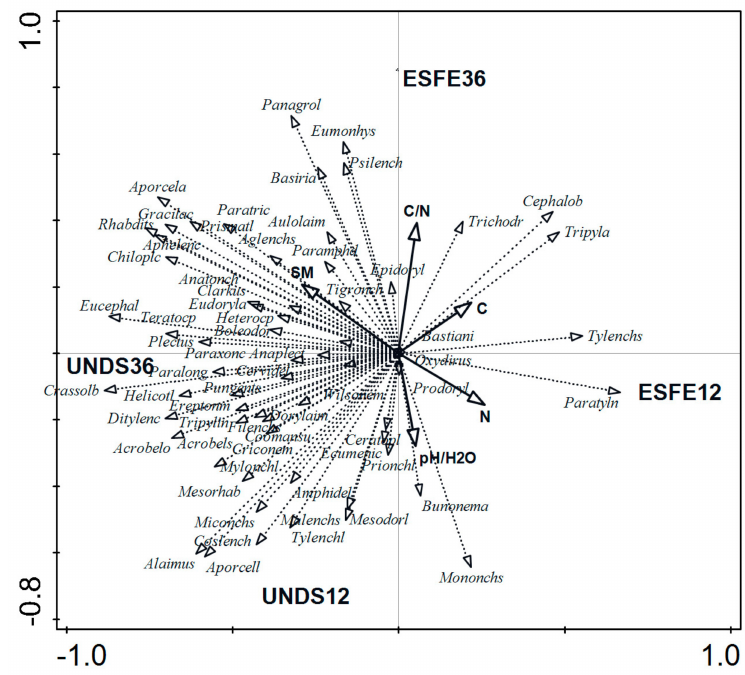
Figure 2. Genus scatter plot of Principal Component Analysis, 1st and 2st axis, log(y + 1) transformed genera abundance, soil attributes in disturbed early-successional forest ecosystems (ESFE12, ESFE36) and undisturbed plots (UNDS12, UNDS36), 12 and 36 months after event. Eigenvalues are 0.229, 0.127, 0.089, and0.075forfirst(horizontal), second(vertical), third, andfourthaxes, respectively. Abbreviations: Acrobels = Acrobeloides; Acrobelo = Acrobeloides; Aglenchs = Aglenchus; Amphidel =